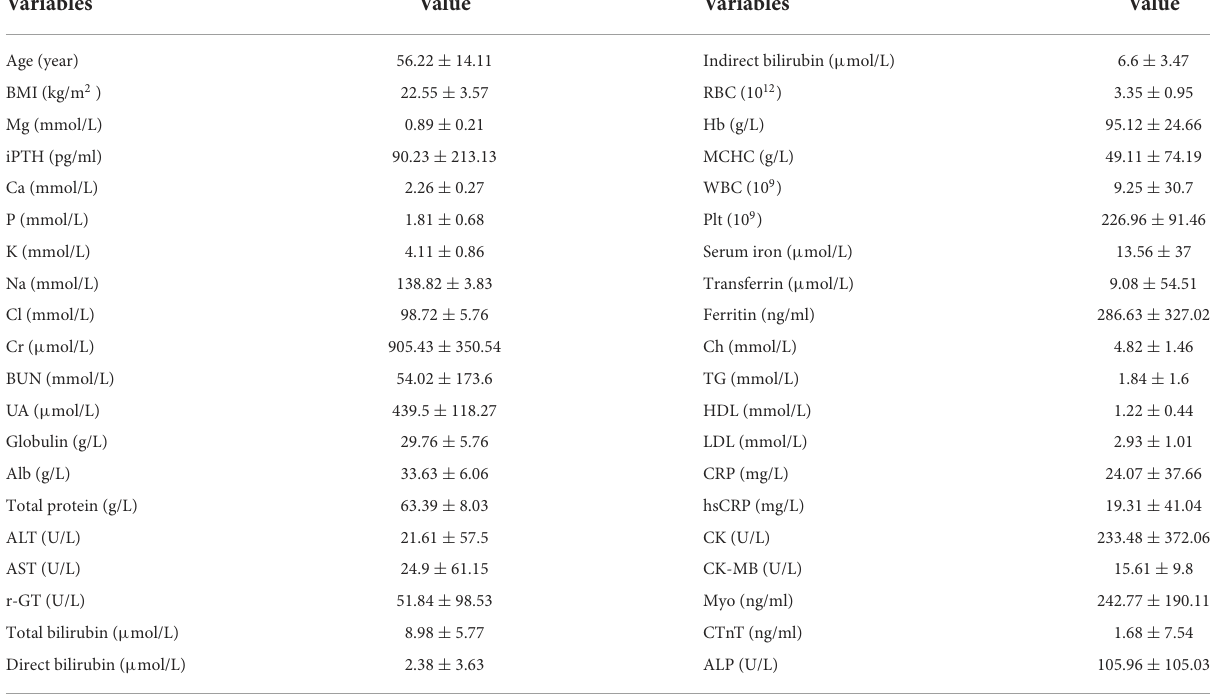
TABLE 1 Baseline data of characteristics of 598